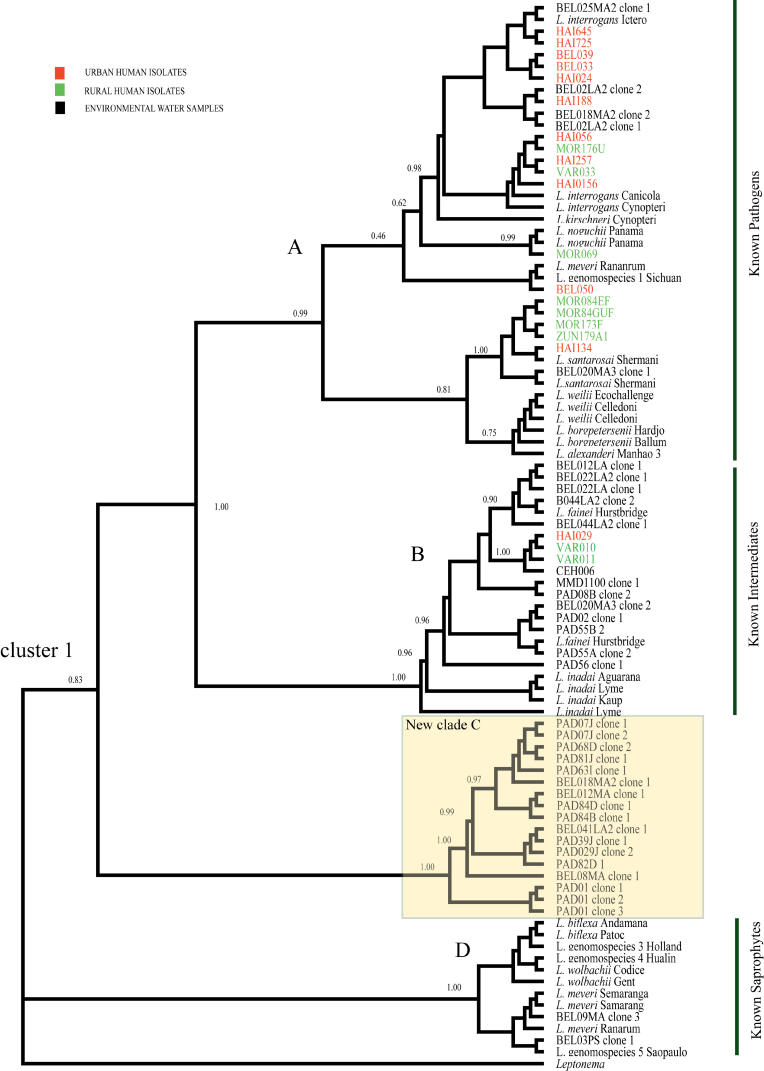
Phylogenetic Analysis of Leptospiral 16s rRNA Gene SequencesSequences represent human isolates and clones from environmental water samples obtained during a prospective study of leptospirosis in Peru using a Bayesian approach. The top cluster (A) comprises strains of the most pathogenic leptospiral species; also included are intermediates (B), the new clade (Clade C) (C), and saprophytes (D). Numbers at each node represent the posterior probability of the given node. Nodes without support values had less than 50% posterior probability, but are consistent with the overall branching of the tree. BEL indicates isolates obtained from patients seen in Belen, a busy riverside market community frequented by Rattus spp.; HAI indicates isolates obtained from patients seen at the Hospital de Apoyo; both are within the urban/periurban center of Iquitos (highlighted in red). Human isolates from rural areas (green) have been designated MOR (Moralillo), VAR (Varillal), and ZUN (Zungarococha) consistent with the location of the villages at which the patients were seen and the cultures obtained. Clones from water samples from Belen have been designated BEL (LA, living area; MA, market area), and samples from Padrecocha as PAD. Nodes highlighted with an asterisk (*) have support values less than 50%, but are consistent with the overall branching of the tree. Padrecocha is a rural area with a significantly lower rat population density but with many pigs roaming free.